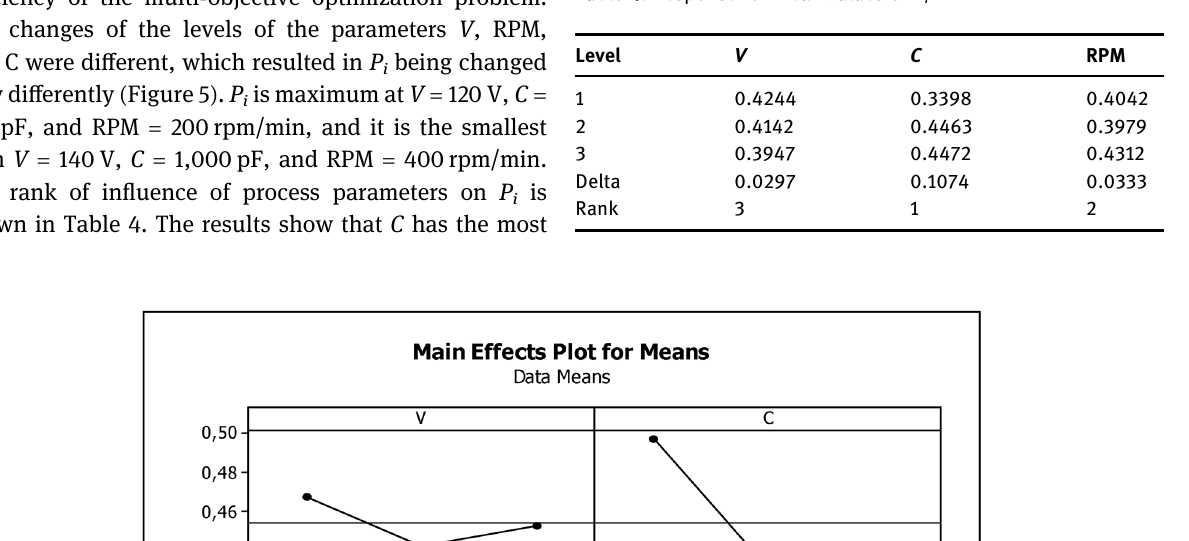
Table 4: Response for mean values of P